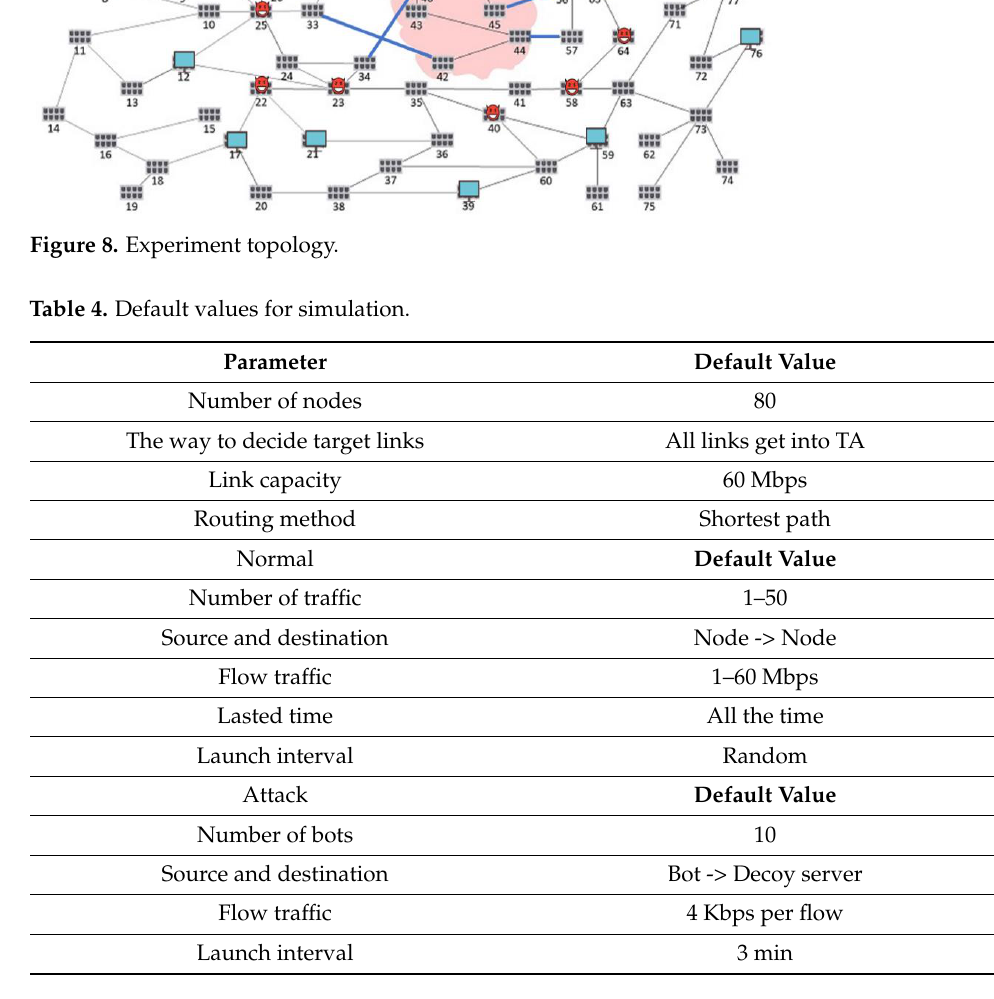
Table 4. SCL parameter setting.